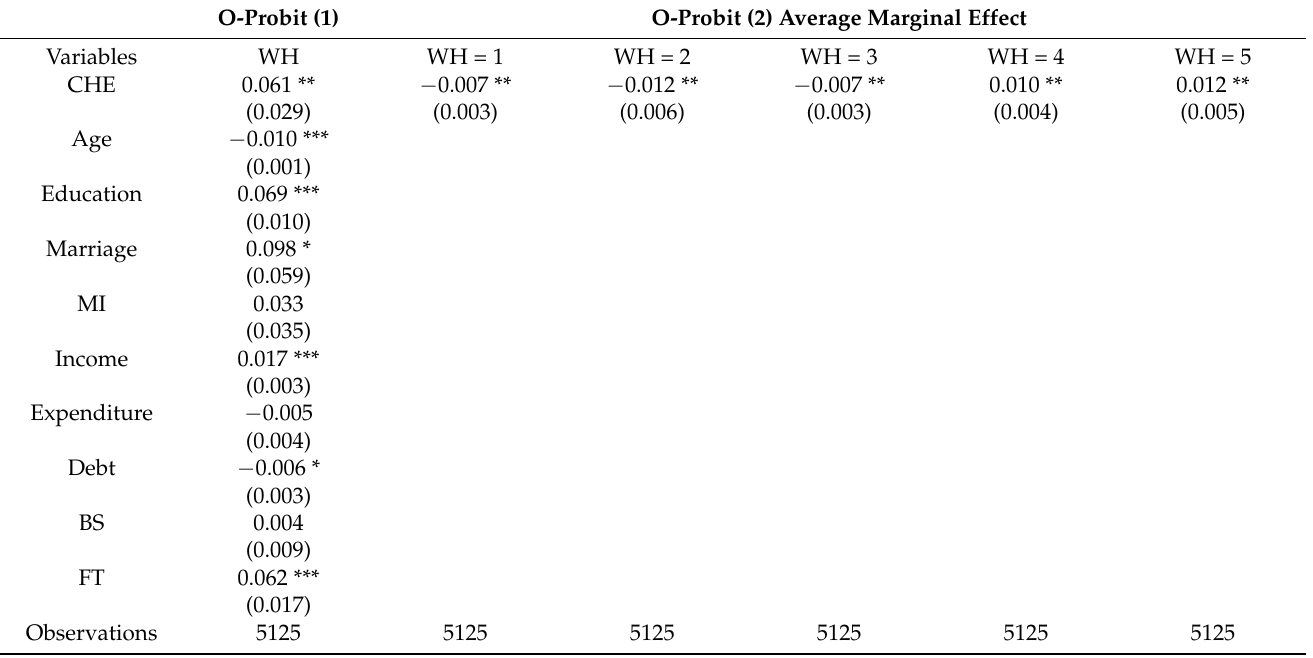
Table 3. The regression results of CHE and